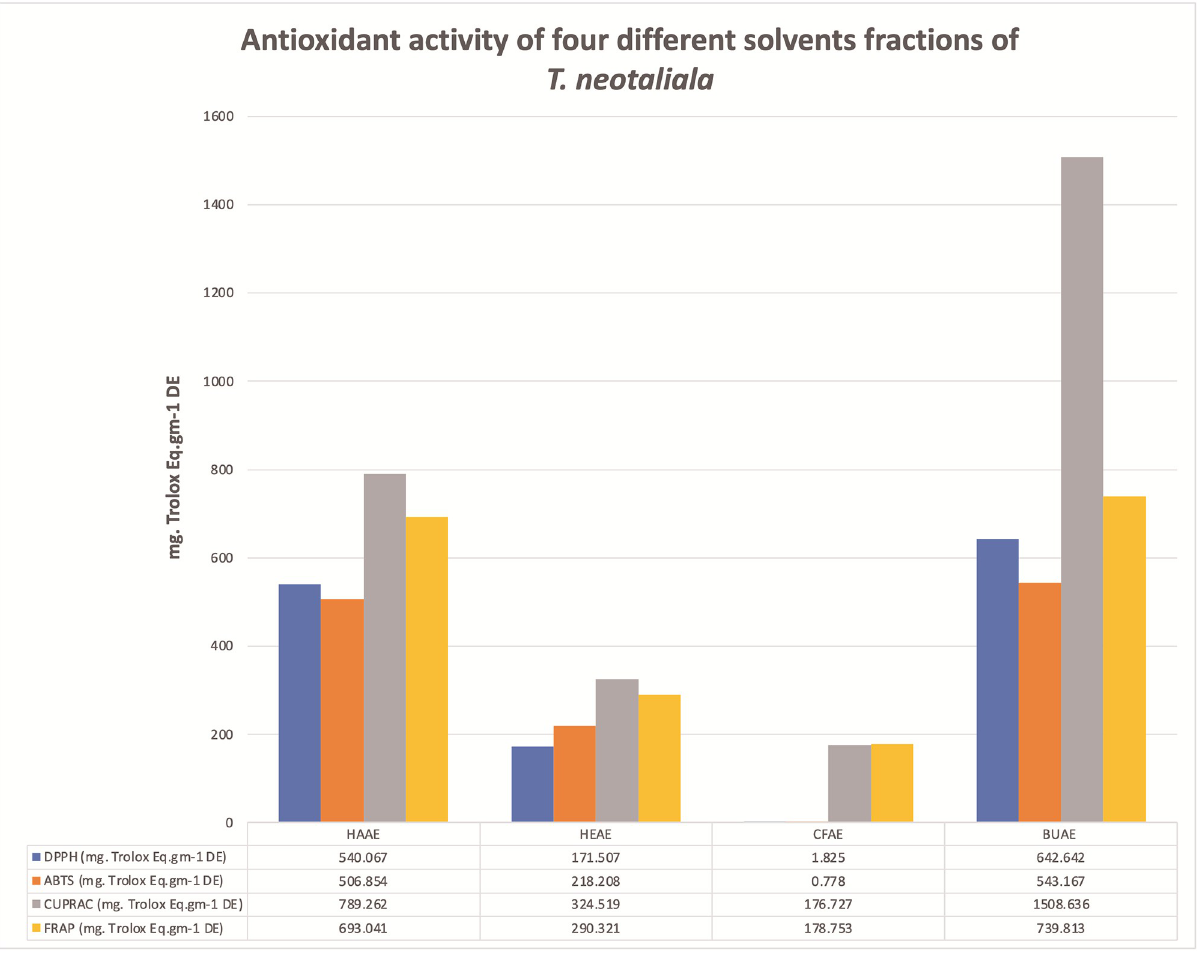
Fig 21. Antioxidant activity of four sample extracts of T . neotaliala determined by DPPH, ABTS, CUPRAC, and FRAP assays. The antioxidant results were statistically analyzed by one-way ANOVA using SPSS software, that the antioxidant content of each sample extract was significantly different from the antioxidant content of others (p-value < 0.05) which indicated that each solvent had a different capacity to extract phytoconstituents depending on its polarity and chemical structure.